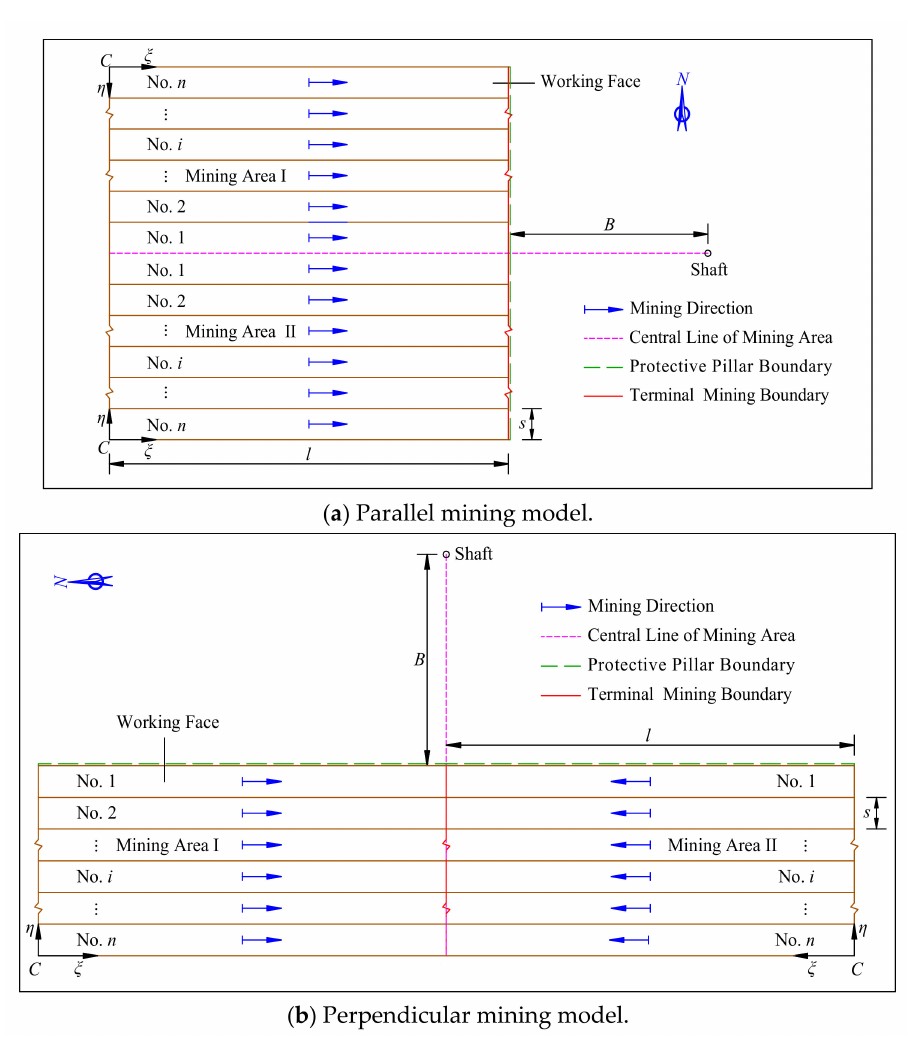
Figure 2. Schematic diagram of the mining